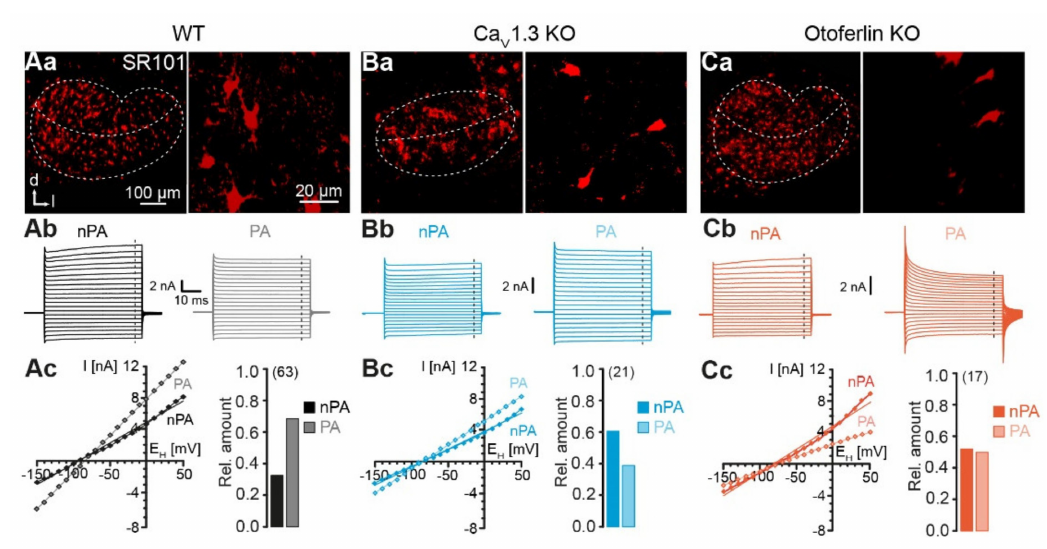
Figure 2. Identification and characterization of LSO astrocytes. ( A – C ), identification of astrocytes in the LSO. Confocal images of SR101-labeled astrocytes in the LSO ( left ). SR101-labeling was independent from genetic modification of mouse strains ( Aa , Ba , Ca ). The border of the LSO and the tonotopic axis are highlighted with dashed lines. In the WT and otoferlin KO mice, the LSO displayed the typical kidney-like shape ( Aa , Ca ). In Cav1.3 KO mice, the LSO was elliptic ( Ba ). Higher magnification of SR101-labeled astrocytes in the center of the LSO ( right ). Electrophysiological characterization of astrocytes ( Ab – Cc ). Astrocytes were recorded in voltage-clamp mode and step-wise hyper- and depolarized. Non-passive astrocytes (nPA) expressed time- and voltage-dependent outward currents ( left ). Passive astrocytes (PA) exhibited only ohmic currents ( right ) ( Ab , Bb , Cb ). Current-voltage ( I / V ) relationship was determined at the end of the voltage steps (dashed lines in Ab , Bb , Cb ). Due to the presence of outward currents, nPAs and PAs exhibited non-linear and linear I / V relationships, respectively ( left ) ( Ac , Bc , Cc ). Relative amount of n / PAs ( right ). The number of analyzed cells is given in parentheses. The WT data ( Aa – Ac ) were part of [9]. Panels Aa left, Ab right, and parts of Ac left were reused from that